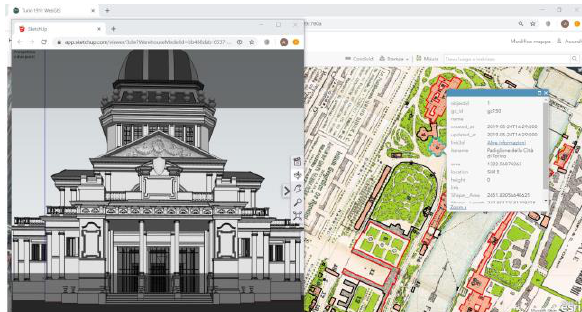
Figure 19. First test for the WebGIS visualization that enable to connect the geometry of the Pavilion of the City of Turin with associated information and the 3D